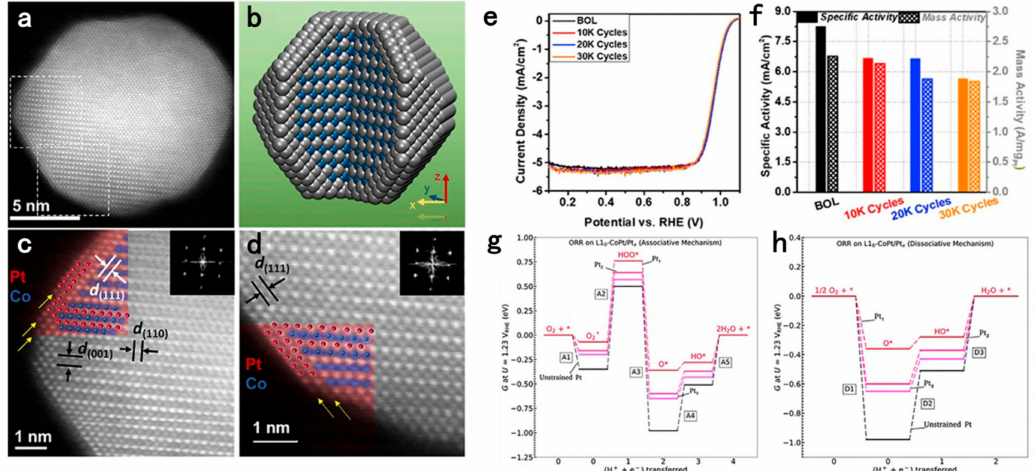
Figure 6. ( a ) STEM image of L1 0 -CoPt/Pt NPs with 2–3 atomic layers of Pt shell over L1 0 -CoPt core (darker atom is Pt and lighter atom is Co), zone axis is the <1–10> direction. Scale bar, 5 nm. ( b ) Schematic of L1 0 -CoPt/Pt NPs with 2–3 atomic layers of Pt shell, where the silver-colored atom is Pt and the blue-colored atom is Co. ( c , d ) Enlarged sections indicated by dashed squares (top square region, c, bottom square region, d in ( a ), showing the 2–3 atomic layers of Pt shell (indicated by yellow arrows) and the L1 0 -CoPt core, Pt is colored in red and Co is colored in blue. Scale bars, 1 nm. ( e ) ORR polarization curves of L1 0 -CoPt/Pt obtained at BOL and EOL. ( f ) Specific activity and mass activity of L1 0 -CoPt/Pt measured at 0.9 V (versus RHE) at BOL and EOL (10,000 cycles, 20,000 cycles, and 30,000 cycles). Free energy diagram calculated via DFT method on associative pathway ( g ) and on dissociative pathway ( h ) for L1 0 -CoPt/Ptx (111) surface (x = 1–3 Pt overlayers) and unstrained Pt (111) surface [118]. Copyright 2019